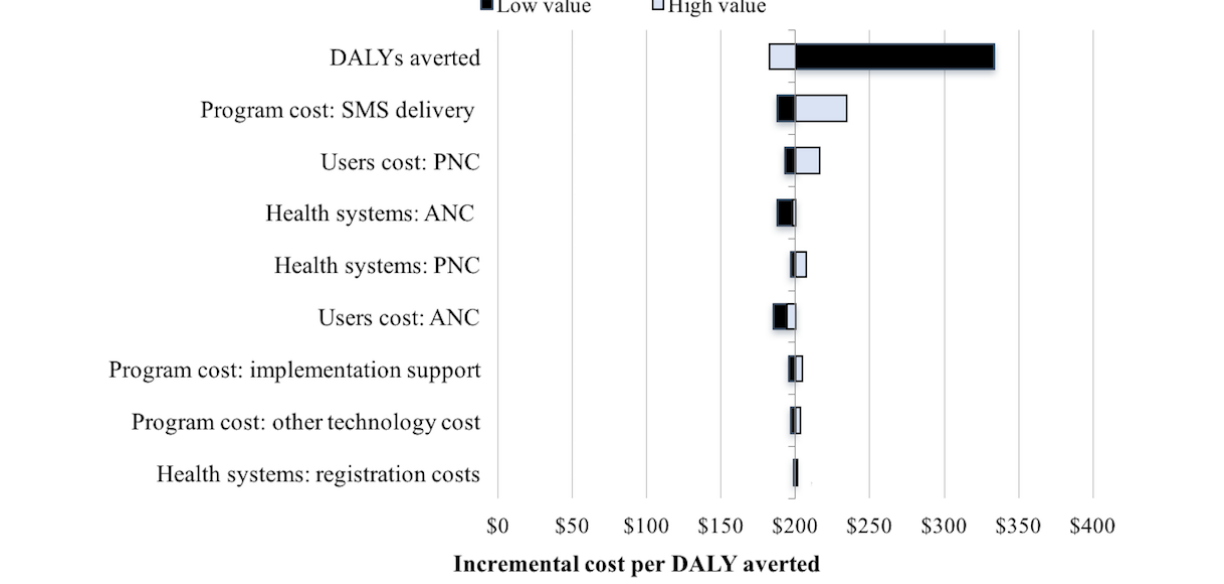
Figure 5. One way sensitivity analysis of key drivers of incremental cost per disability adjusted life year (DALY) averted for year 5 of program implementation (all costs in US $). ANC: antenatal care; PNC: postnatal care; SMS: short message